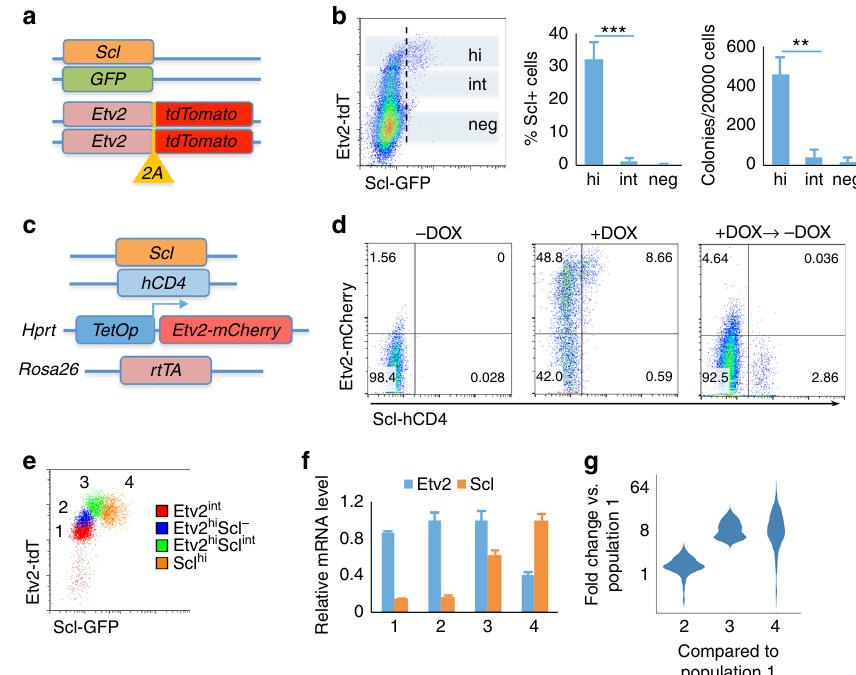
Fig. 1 Etv2 threshold expression determines hemangiogenic fate. a Scheme of SGET ES cells. b Etv2-tdTomato and Scl-GFP expression in D4 SGET EBs analyzed by fl ow cytometry is shown on the left . The percentages of Scl-GFP + cells ( right side of the vertical dashed line ) within Etv2-tdTomato hi(gh) , Etv2-tdTomato int(ermediate) and Etv2-tdTomato neg(ative) cells ( shaded regions ) are shown in the middle . Blast colony number obtained from sorted Etv2 neg , Etv2 int , and Etv2 hi cells is shown on the right . c Scheme of iEtv2-mCherry ES cell line. d iEtv2-mCherry EB cells differentiated in serum-free conditions were analyzed for Etv2-mCherry and Scl-hCD4. – DOX, no DOX control, +DOX, DOX was added from D2.5 to D3.5 at a concentration of 2 μ g/mL, +DOX → − DOX, DOX was added from D2.5 to D3.5, washed off and then cells were cultured for additional 2 days. – DOX and +DOX EBs were analyzed on D3.5. +DOX → − DOX EBs were analyzed on D5.5. e Flow cytometry plot of the four populations, 1 Etv2-tdTomato int , 2 Etv2-tdTomato hi /Scl-GFP -(negative) , 3 Etv2-tdTomato hi Scl-GFP int , and 4 Scl-GFP hi from D4 SGET cells after sorting is shown. f Normalized relative mRNA level of Etv2 and Scl in the sorted populations is shown. The mRNA level of Etv2 and Scl was fi rst normalized to Gapdh , and then the maximal value within the group was rescaled to 1. g Violin plots showing fold changes of RNA-seq RPKM values of 73 ETV2 target genes in populations 2, 3, and 4, respectively, compared to population 1. ** P value < 0.01 in Student ’ s t test, *** P < 0.001, and n = 3. Error bars are